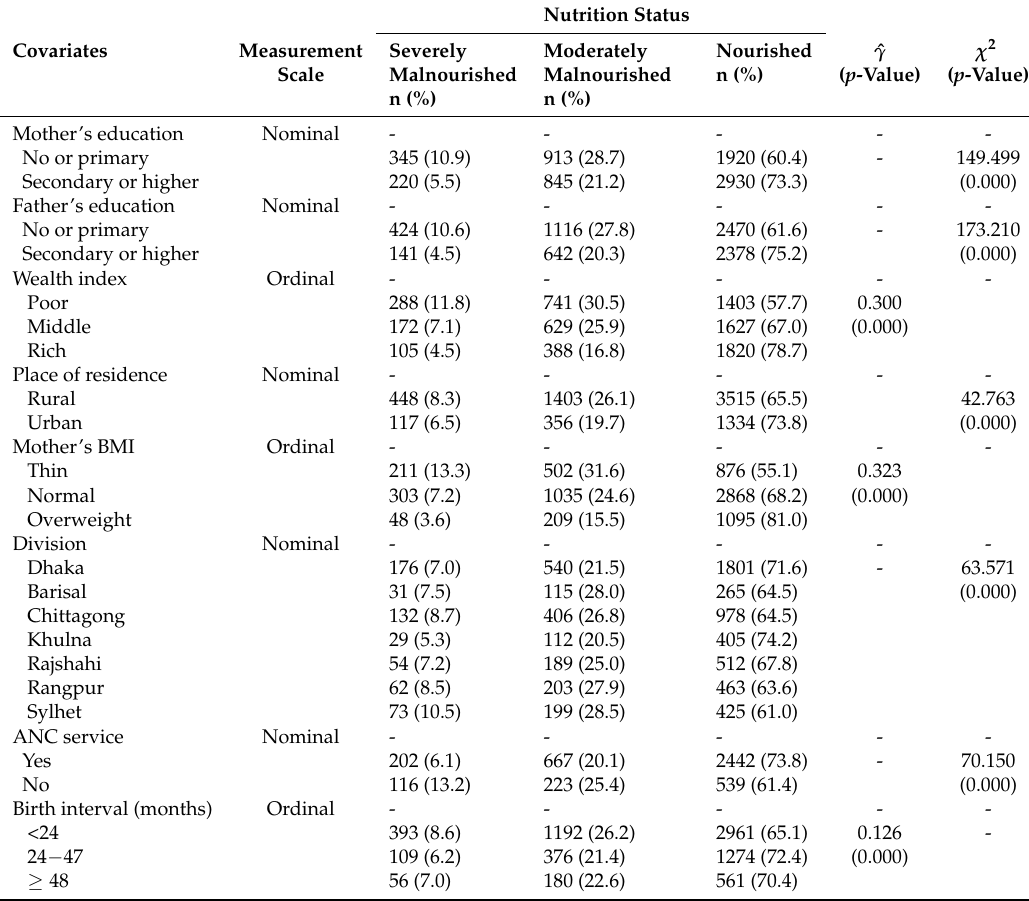
Table 1. Assessing the association between selected covariates and nutrition status of under-five children using gamma measure and chi-square